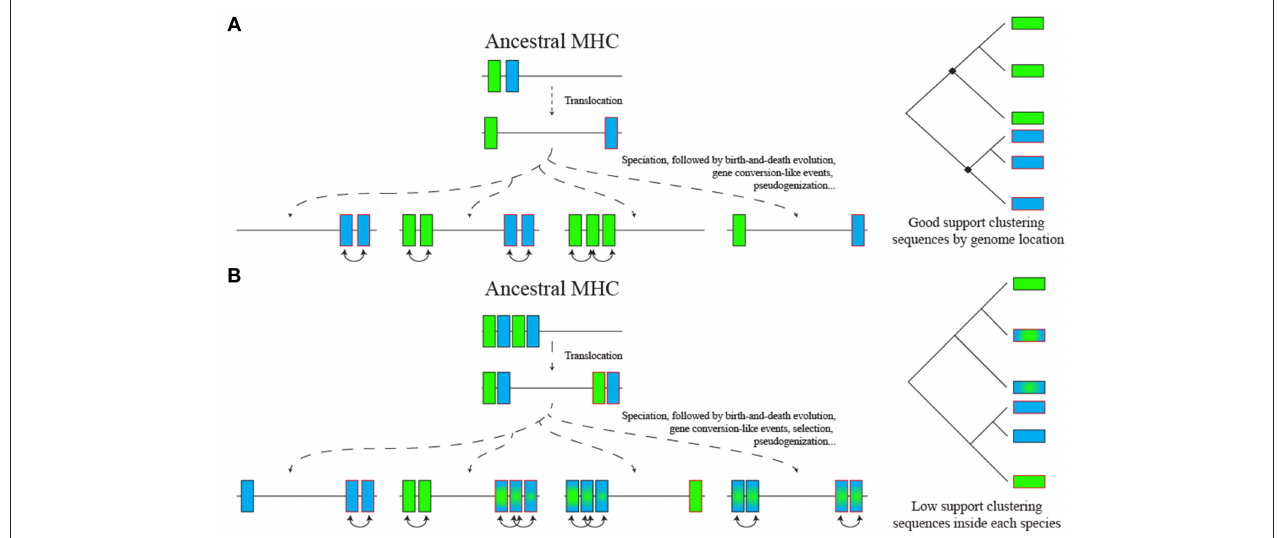
FIGURE 7 | Two scenarios for ancestral MHC class II region evolution and impact on phylogenetic analysis. (A) A simple model with only two paralogs separated by a translocation event. (B) A complex model with in tandem duplication of two loci separated by a translocation event. In the first scenario, translocated genes from current species would cluster together in the phylogeny, while in the second scenario a birth-and-death model of evolution, including gene conversion-like events and differential loss of tandemly duplicated loci, results in no true orthologs across distantly related taxa. Selection acting on both translocated and non-translocated regions can also blur the phylogenetic signal in both scenarios both for exonic and intronic